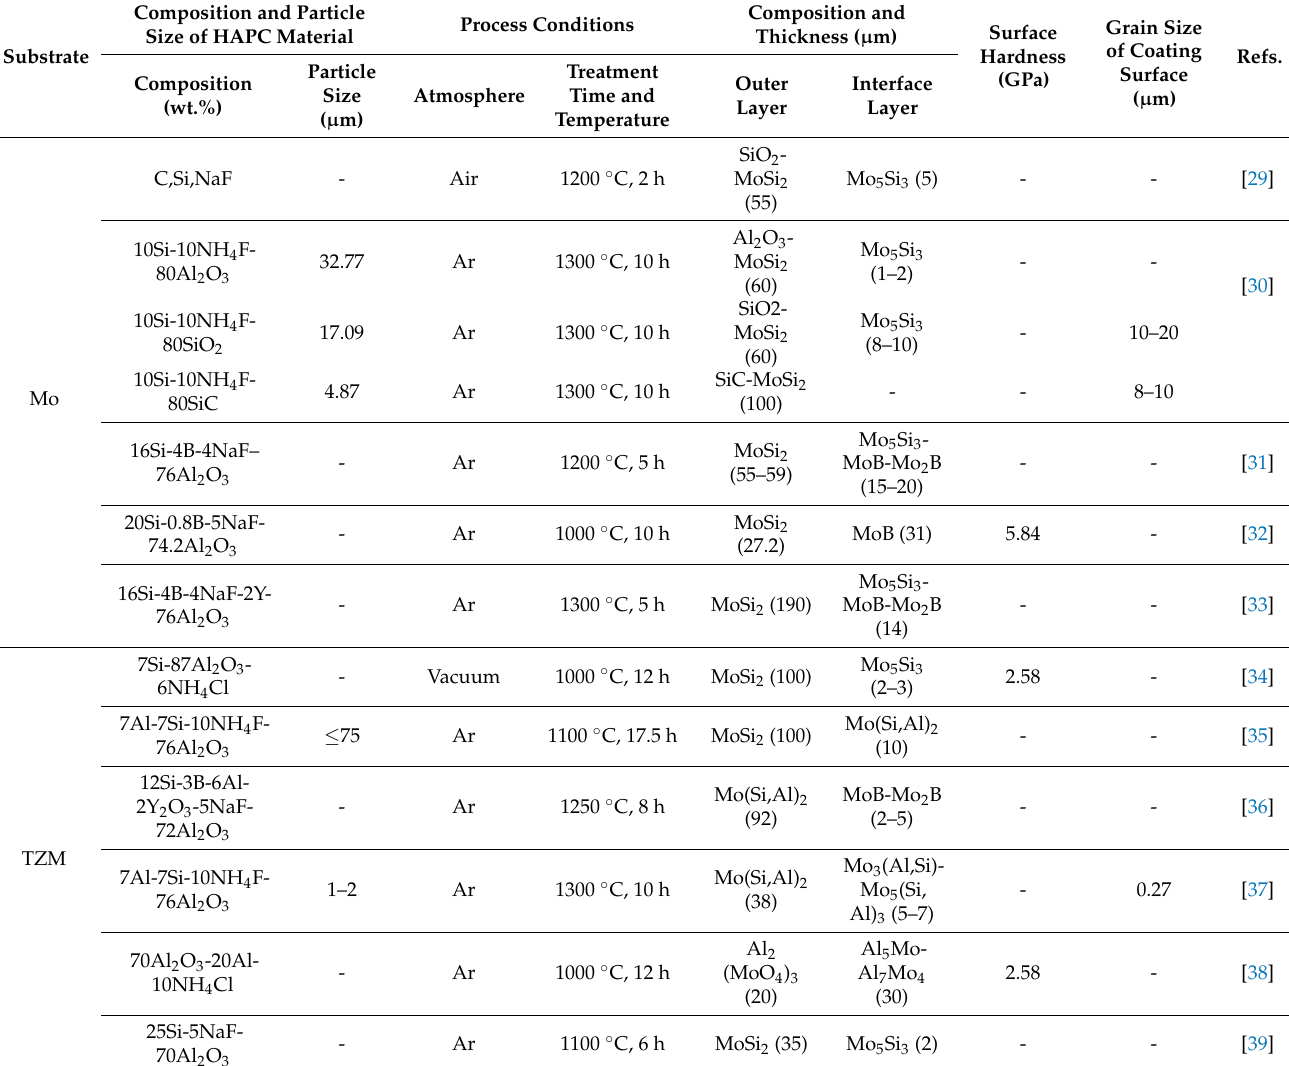
Process Conditions